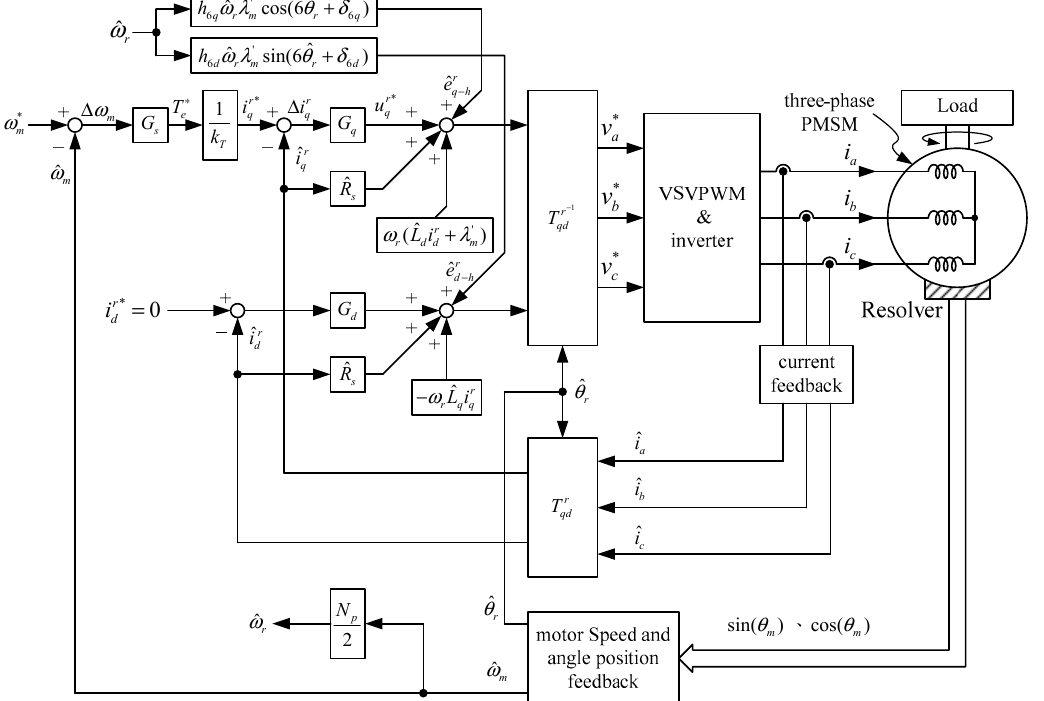
Figure 3. Current harmonics improvement control block of compensation for the induced EMF harmonics along the q-axis and d-axis in the q-axis/d-axis current closed-loop control.